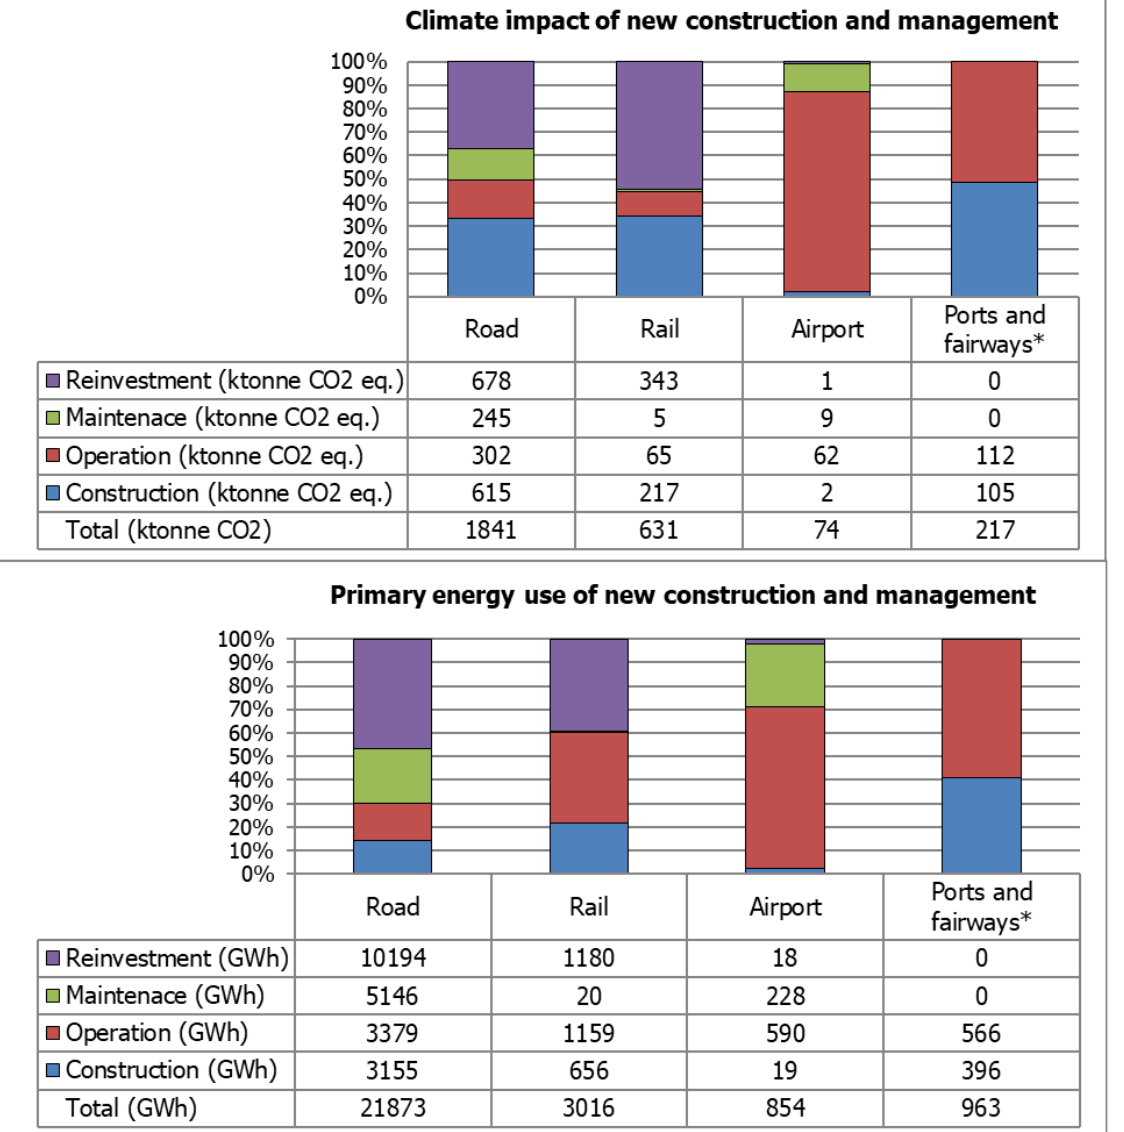
Figure 5. Annual climate impact (ktonne CO 2 equivalents) and primary energy use (GWh) of new construction and management (operation, maintenance, reinvestment) of the infrastructure